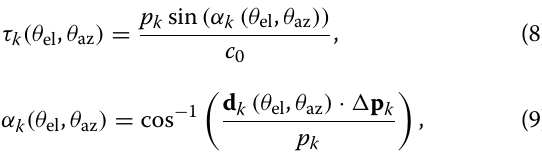
UAV’s propellers, a machine learning approach is pro- posed. The approach sets to estimate the rotor noise PSD using the PSDs of the microphone input signals, removing any irrelevant sources present (i.e. target sound source), before using this information to design a noise filter specifically removing UAV rotor